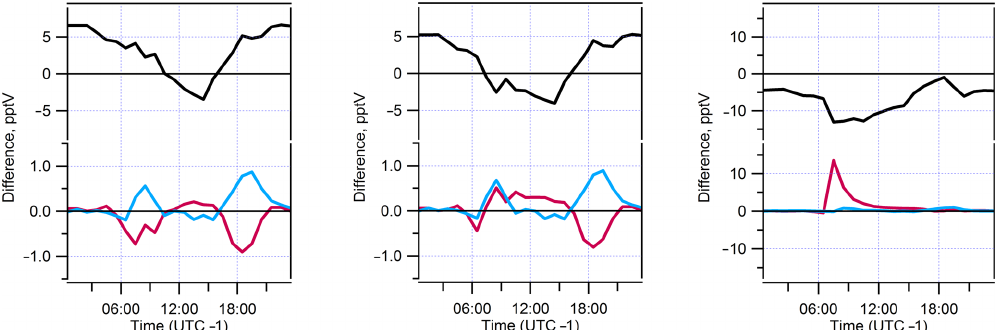
Figure 7. Sensitivity analysis of the effect of changing reactive uptake coefficients ( γ) of halogen nitrates , XONO 2 (X = Br, I), on NO x (top), and XO (bottom) diurnal behaviour during summer months at CVO. The difference between measured and modelled values is plotted. Particulate nitrate photolysis is set at 10 times the rate of gaseous HNO 3 . NO x – black; IO – turquoise; BrO –